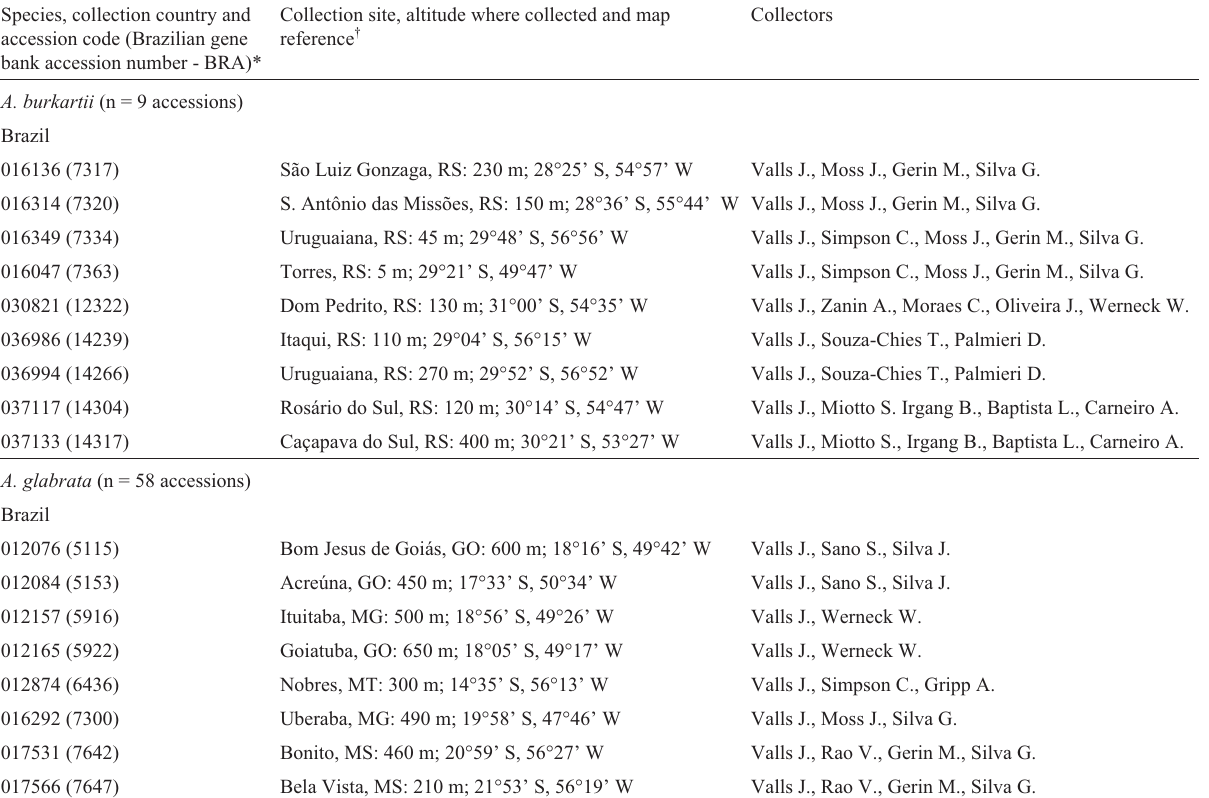
Table 1 - Accessions (n = 77) of the four Arachis species in section Rhizomatosae analyzed using microsatellite markers. Species, collection country and Collection site, altitude where collected and map accession code (Brazilian gene reference bank accession number - BRA)*